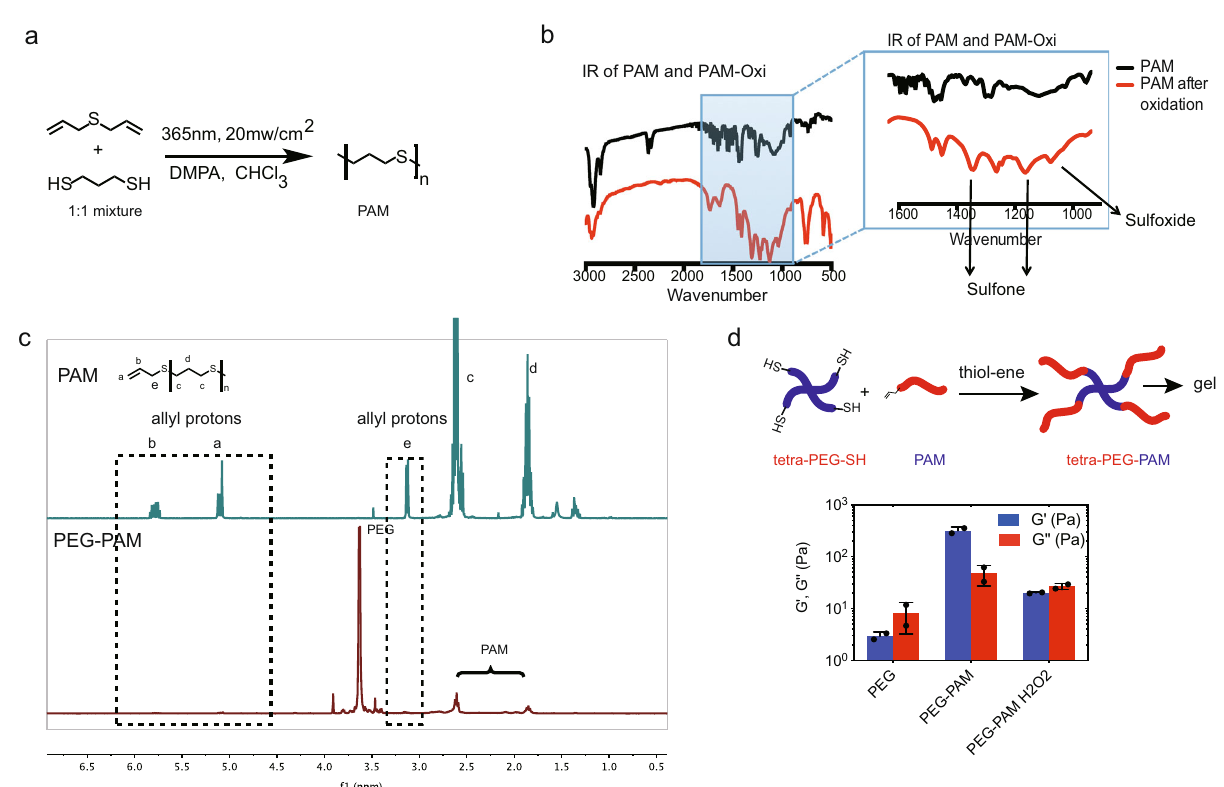
Fig. 1 One pot synthesis of polyallyl-mercaptan (PAM) via UV activated thiolene chemistry. a Allyl sul fi de, 1,3-Dimercaptopropane, and photoinitiator DMPA are dissolved and mixed in chloroform. Upon activation with UV light polymerization generates PAM. b FT-IR analysis of PAM polymer and PAM polymer after oxidation with 10% H 2 O 2 , which generates sulfone groups. c 1 H-NMR of PAM and PAM after conjugation of tetra-PEG-SH via UV activated thiol-ene chemistry. Allyl protons are consumed in the reaction with PEG-SH. d PEG-PAM at 4 weight % self assembles to form a gel, G ’ >G ” . Rheometer measurement of modulus of 4% of tetra-PEG-SH, PEG-PAM, PEG-PAM after oxidation in PBS. Data is plotted showing the mean and Standard Deviation. Biological replicates derived from independent experiments are shown as a dot ( n =